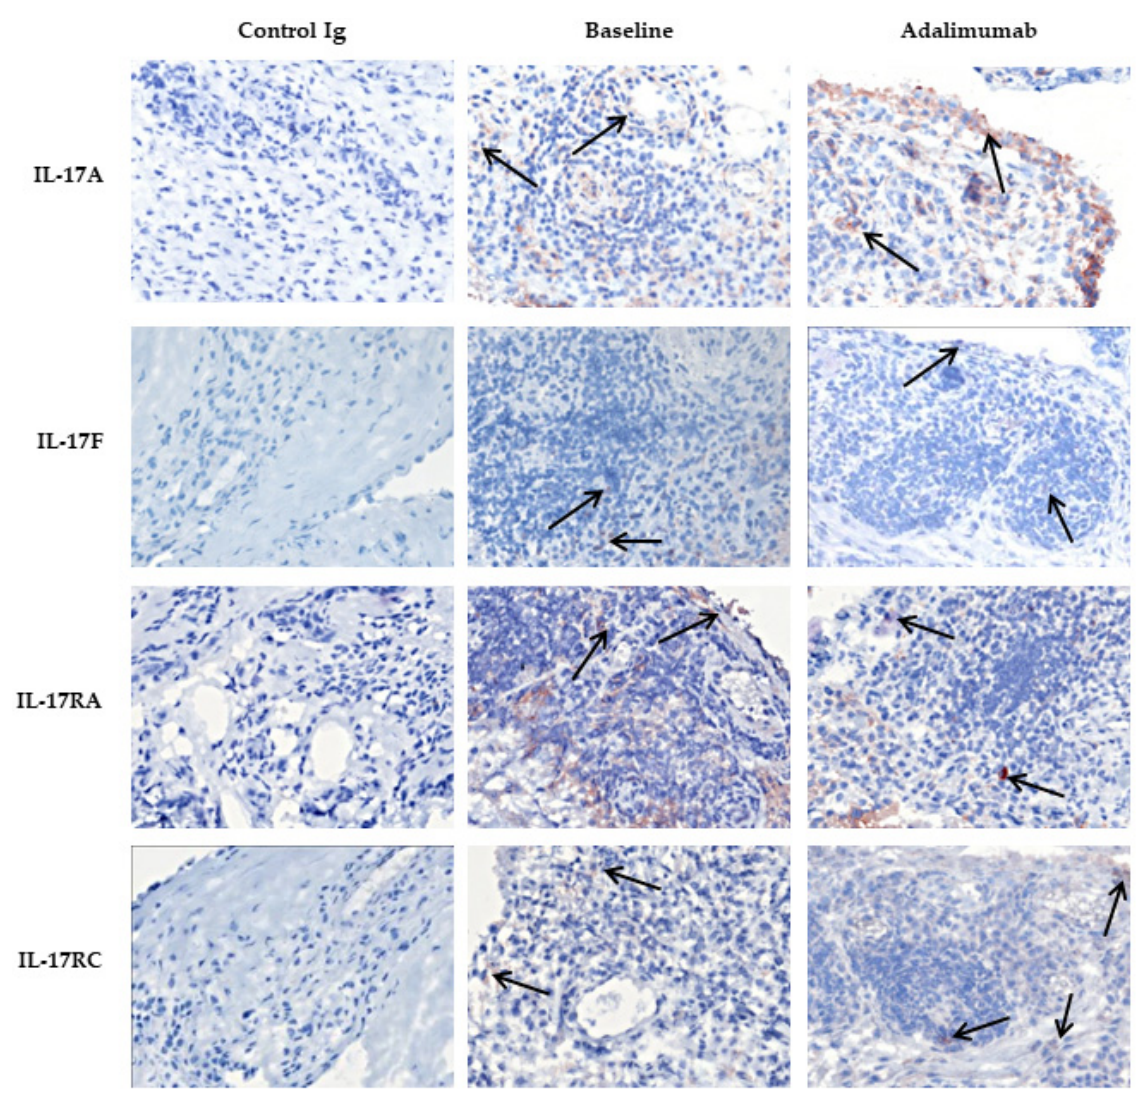
Figure 6. Representation of expression of IL-17A, IL-17F, IL-17RA and IL-17RC (arrows) in synovial tissue of one PsA patient before and after adalimumab treatment. Expression was not altered after 4 weeks of adalimumab. Representative immunohistochemical staining of IL-17A, IL-17F, IL-17RA and IL-17RC expression in synovial tissue of one PsA patient before (baseline) and after treatment with adalimumab. Original magnification 200 × . IL, interleukin; PsA, psoriatic arthritis. Adalimumab treatment did not affect the expression of IL-17A, IL-17F, IL17RA or IL-17RC in PsA synovial tissue compared to the tissue of the placebo group, as all ANCOVA p -values were above 0.05 (Table 3). This was also illustrated by the